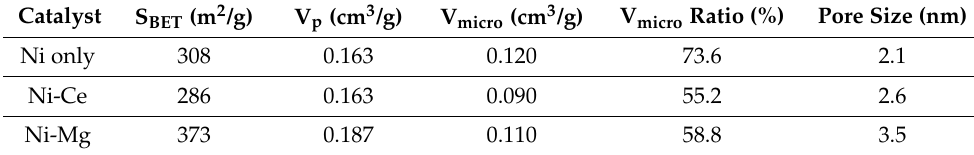
Table 2. BET surface area and pore characteristics of Ni/Eco, Ni-Ce/Eco, and Ni-Mg/Eco.